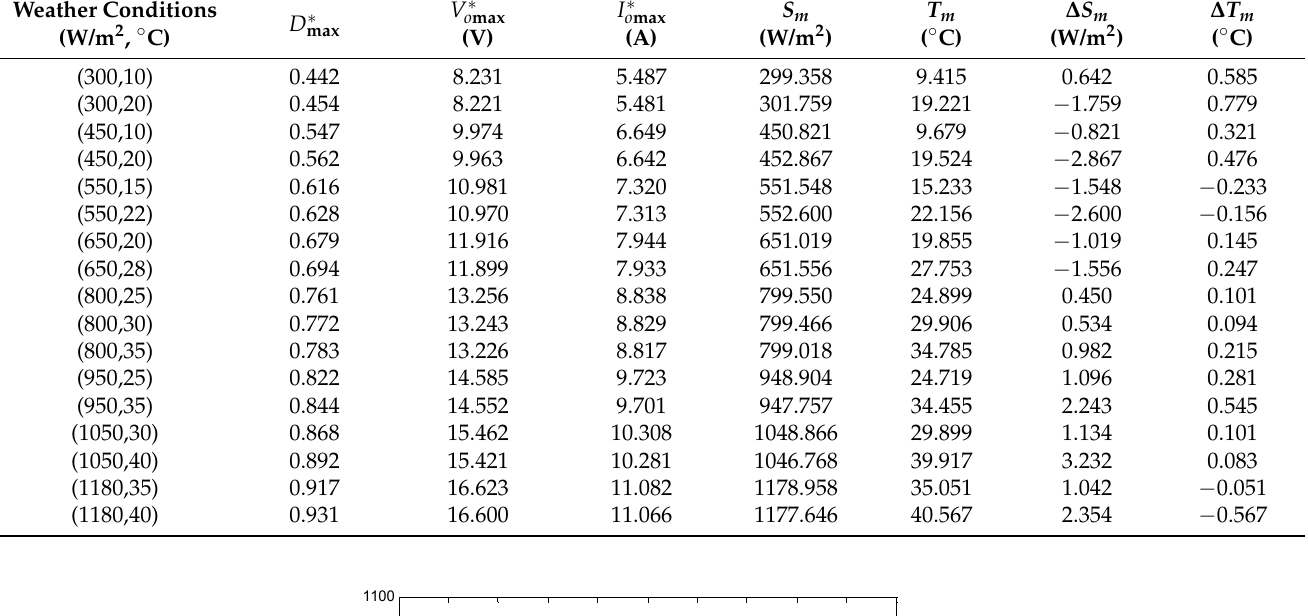
Table 7. Simulation results under arbitrary changeless weather conditions.